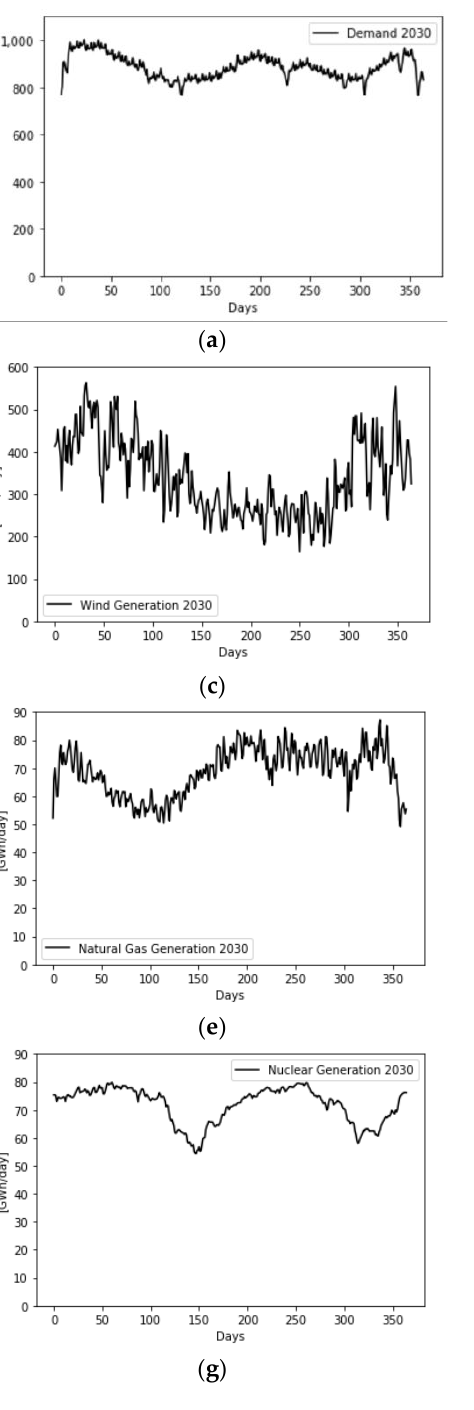
Figure 2. Daily demand, generation, and variable costs for 2030. ( a ) Daily demand for 2030; ( b ) daily hydro generation for 2030; ( c ) daily wind generation for 2030; ( d ) daily solar generation for 2030; ( e ) daily natural gas generation for 2030; ( f ) daily generation by other renewables for 2030; ( g ) daily nuclear generation for 2030; ( h ) daily variable costs for 2030.